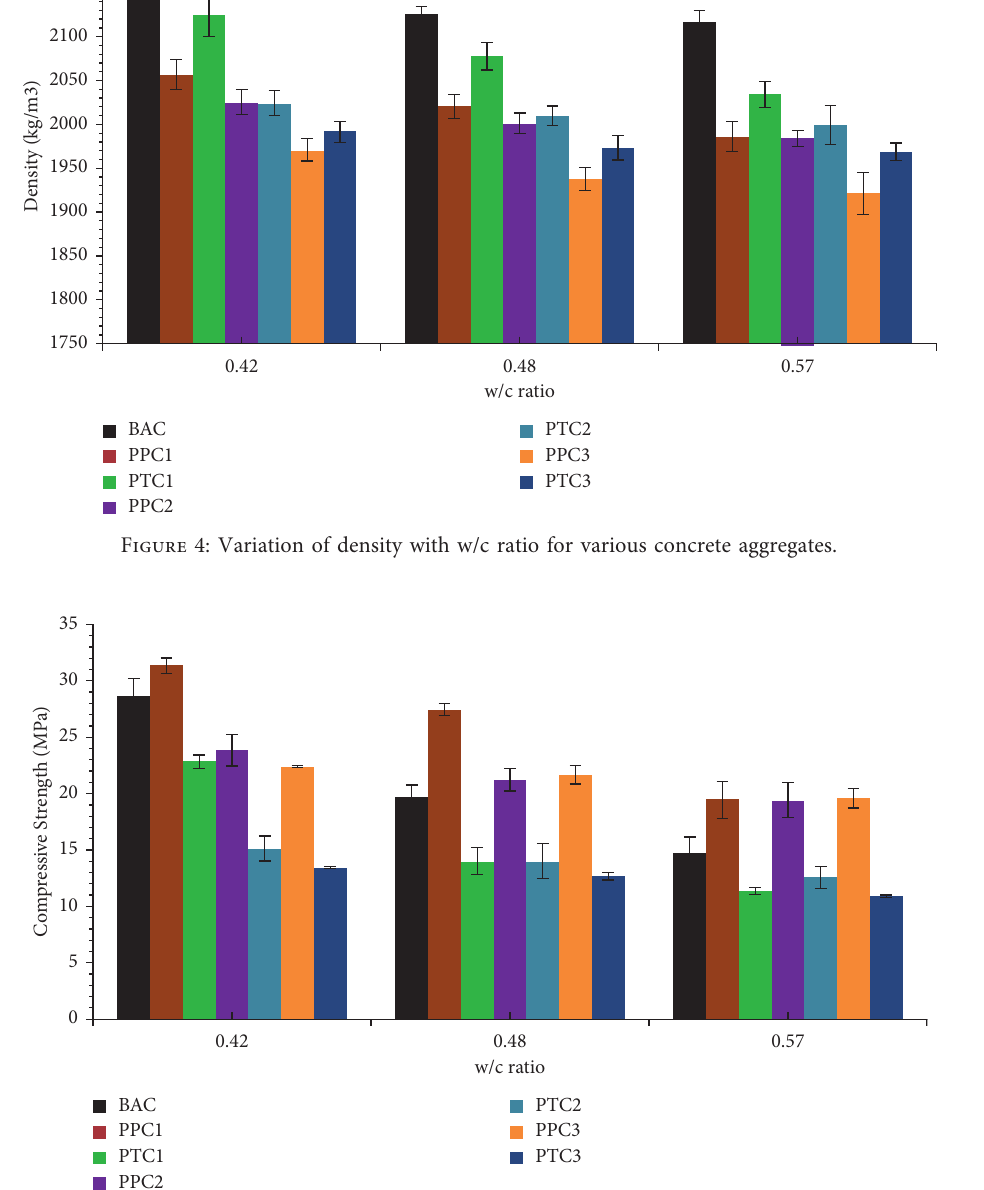
Figure 5: Variation in compressive strength of concrete with w/c